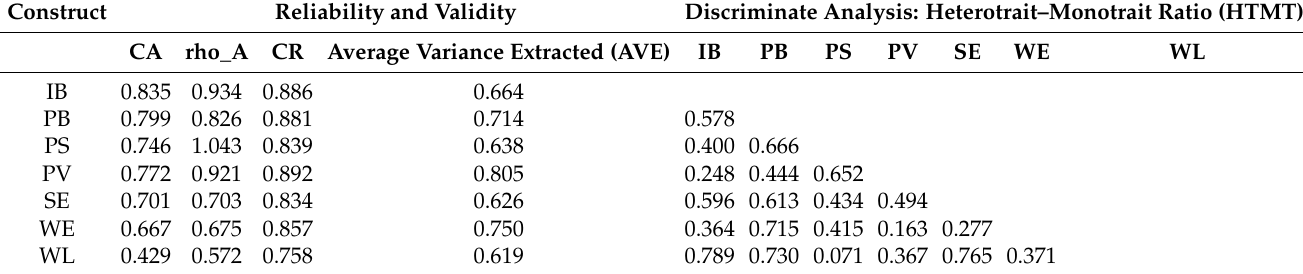
Table 5. Reliability and validity